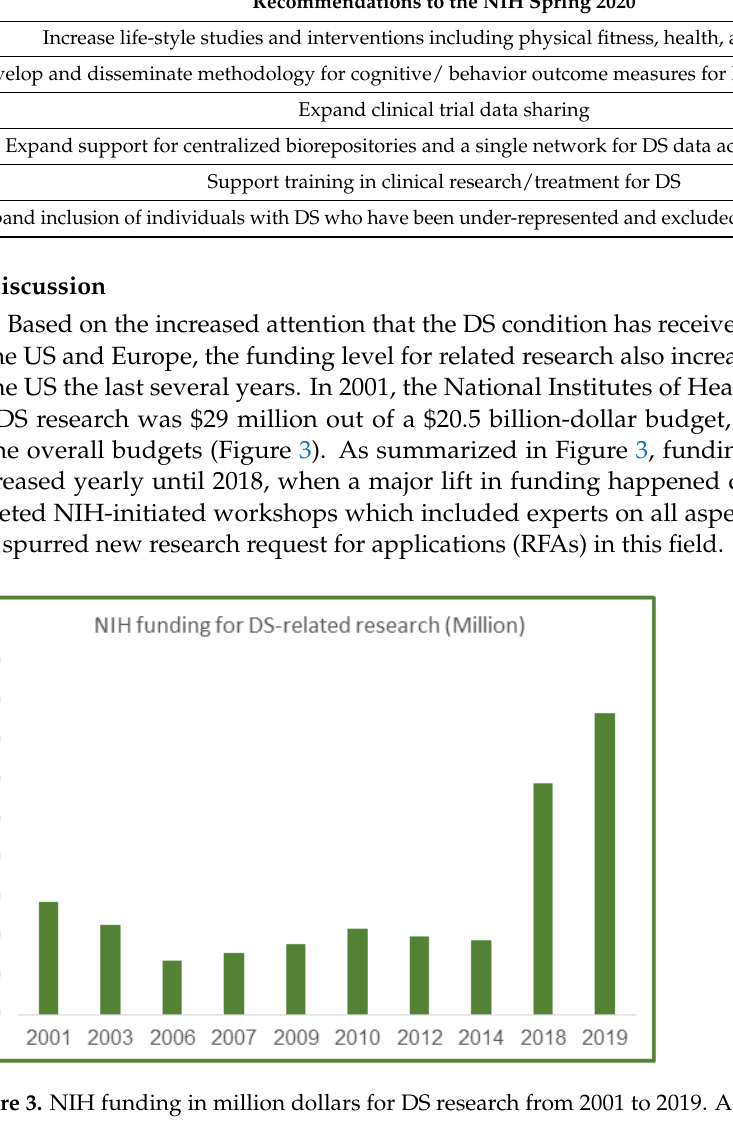
Figure 3. NIH funding in million dollars for DS research from 2001 to 2019. According to the NIH website, total funding for DS research was $29 million in 2001, which has now incrementally increased to more than $70 million in 2019, giving researchers a stellar opportunity to fully investigate clinical comorbidities of DS and AD in the future and with the added guidance provided by the DS NIH plan discussed above.